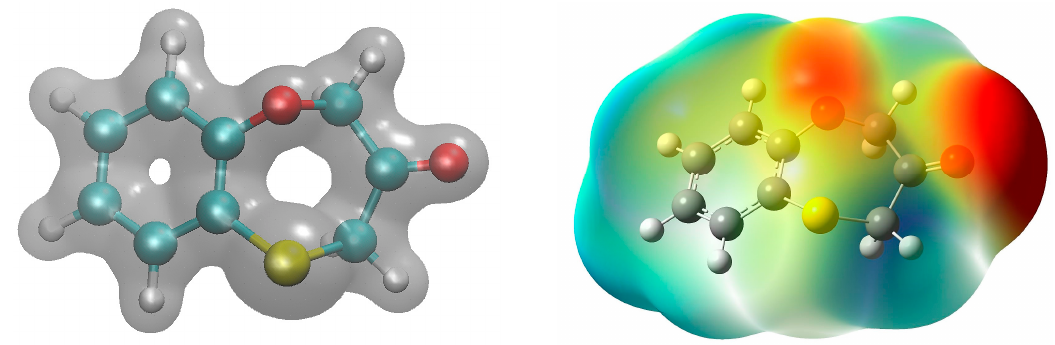
Figure 2. Optimised geometry of 3,4-dihydro-2 H -1,5-benzoxathiepin-3-one ( 6 ): electronic isodensity contour ( left ); colour-mapped with the electrostatic potential ( right ), where red and blue zones are related to the electrophilic and nucleophilic zones of the molecule, respectively.